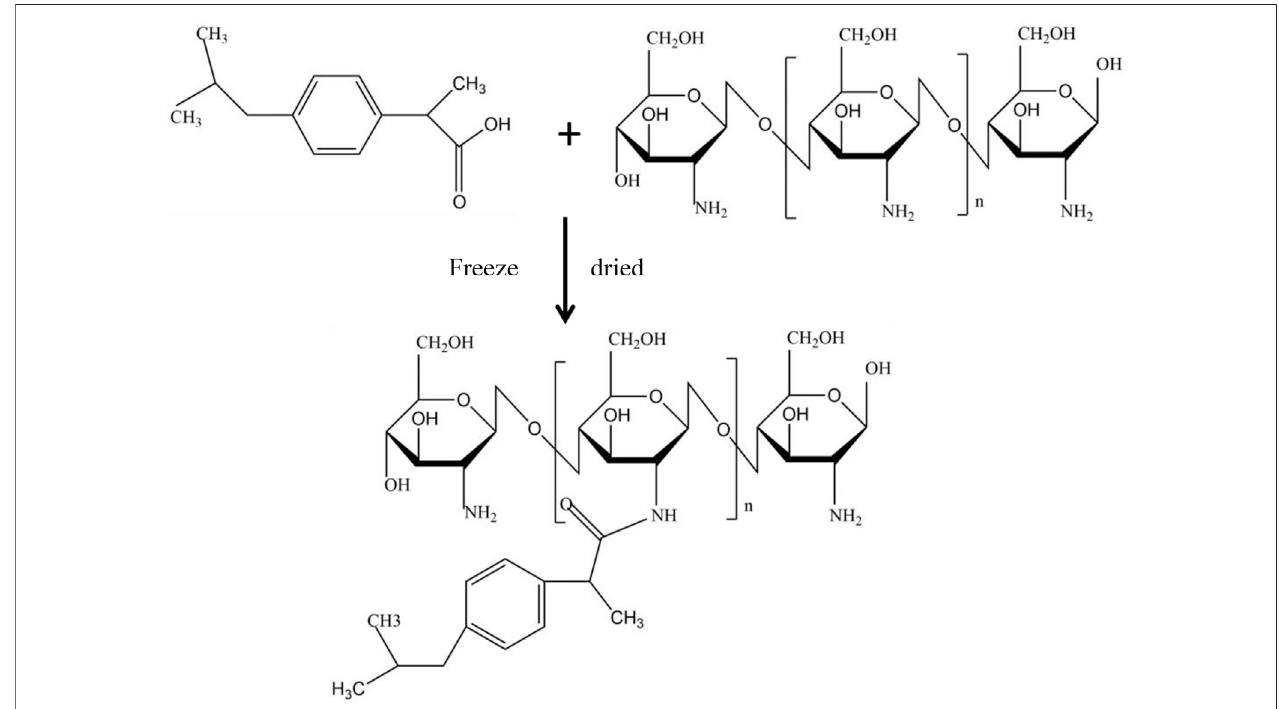
FIGURE 1 | Schematic illustration of the synthetic routes of chitosan – ibuprofen aerogels.